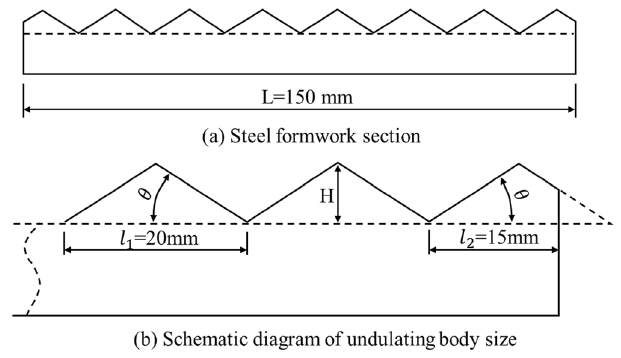
Figure 1. Amplitude of artificial joint surface.